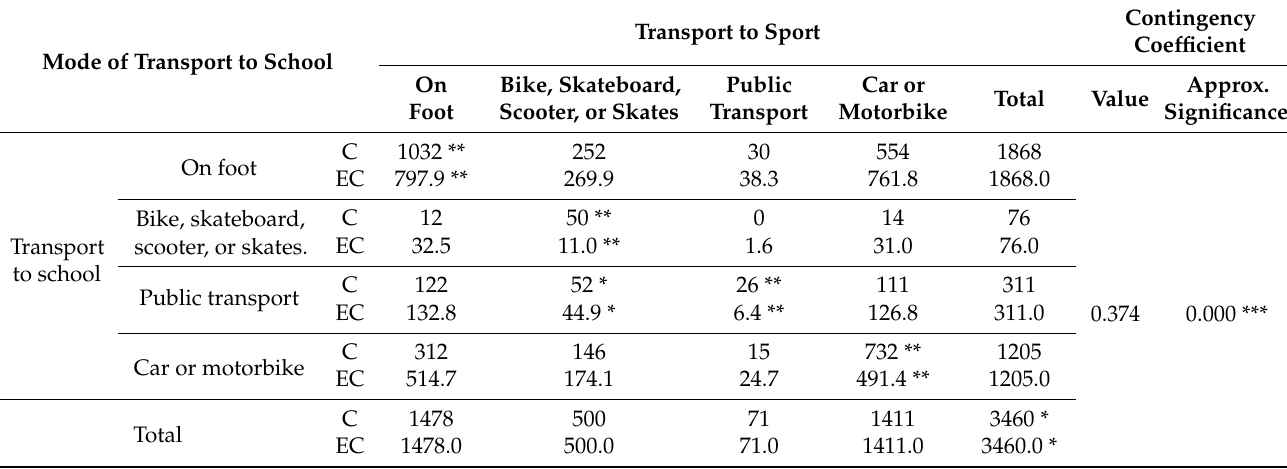
Table 4. Contingency between the variables “mode of transport to school” and “mode of transport to sport” in males. Transport to Sport Mode of Transport to School